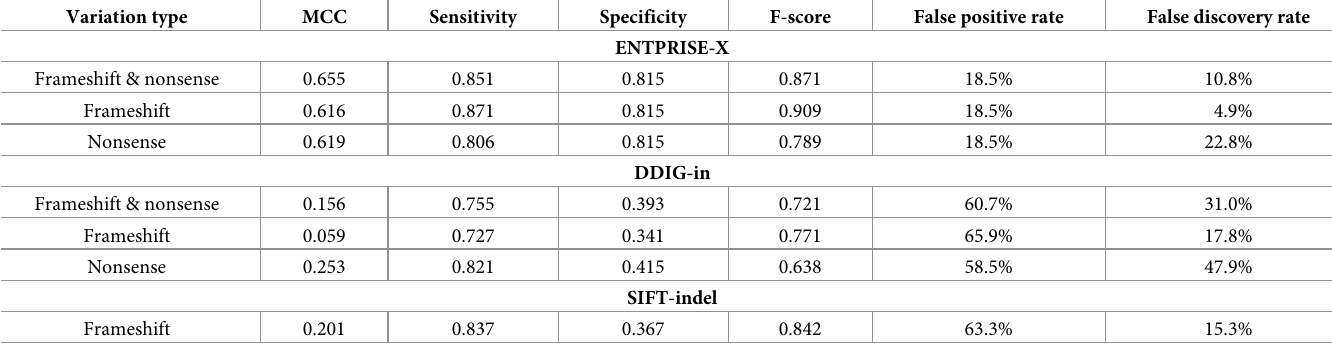
Table 3. Ten-fold cross-validation of ENTPRISE-X on the whole training set a .